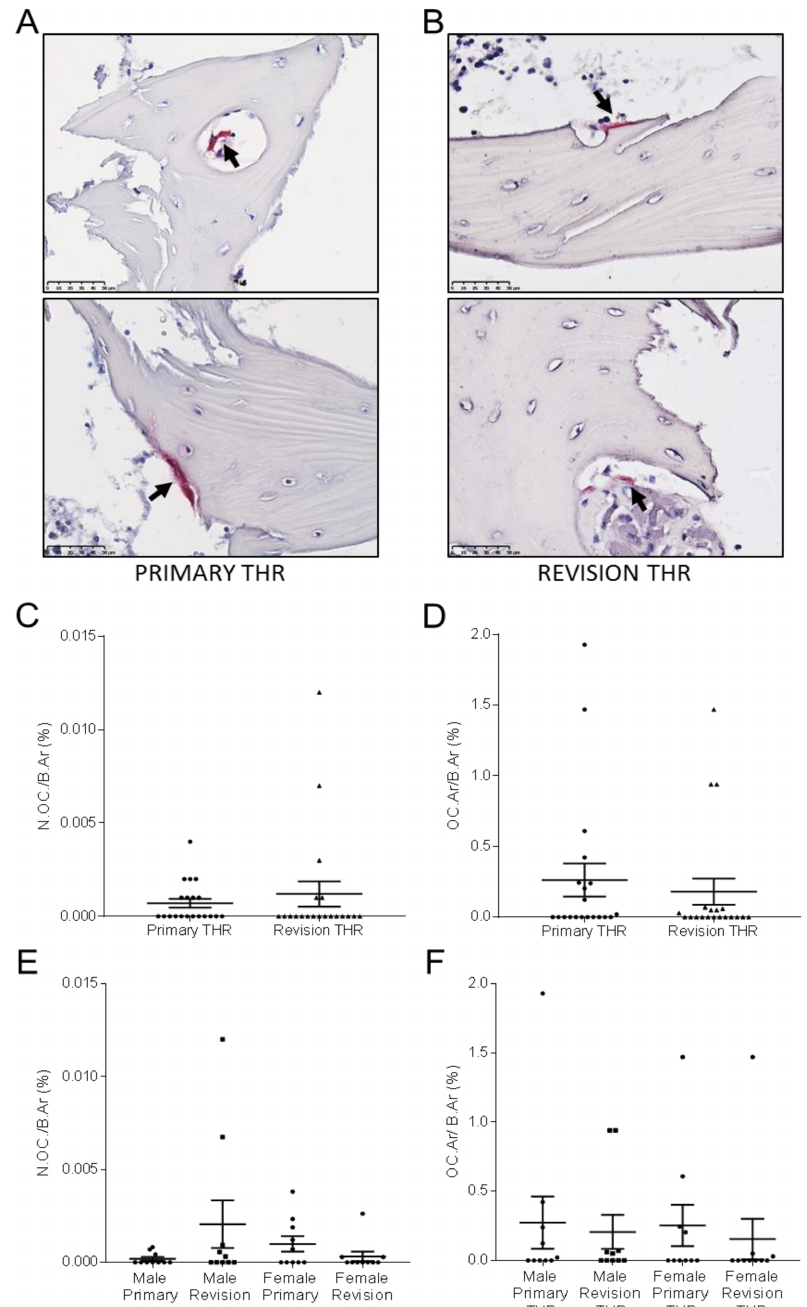
Figure 6. Bone biopsies were obtained from Primary THR ( A ) and Revision THR surgeries ( B ) and stained with TRAP. Images depict sections from two individual patients per group, TRAP positive osteoclasts were observed (black arrow) in both Primary THR and Revision THR cohorts. Osteoclast characteristics for human Primary THR compared to Revision THR biopsies: ( C ) the osteoclast number per bone area (N.OC. / B.Ar (%)) for primary THR compared to revision THR cohort; ( D ) osteoclast area per bone area (OC.Ar / B.Ar (%)) for primary THR compared to revision THR cohort; ( E ) osteoclast number per bone area (N.OC. / B.Ar (%)) for Male Primary THR, Male Revision THR, Female Primary THR and Female Revision THR cohorts; ( F ) osteoclast area per bone area (OC.Ar / B.Ar (%)) for Male Primary THR, Male Revision THR, Female Primary THR and Female Revision THR cohorts. Data shown are means ± standard error of the mean